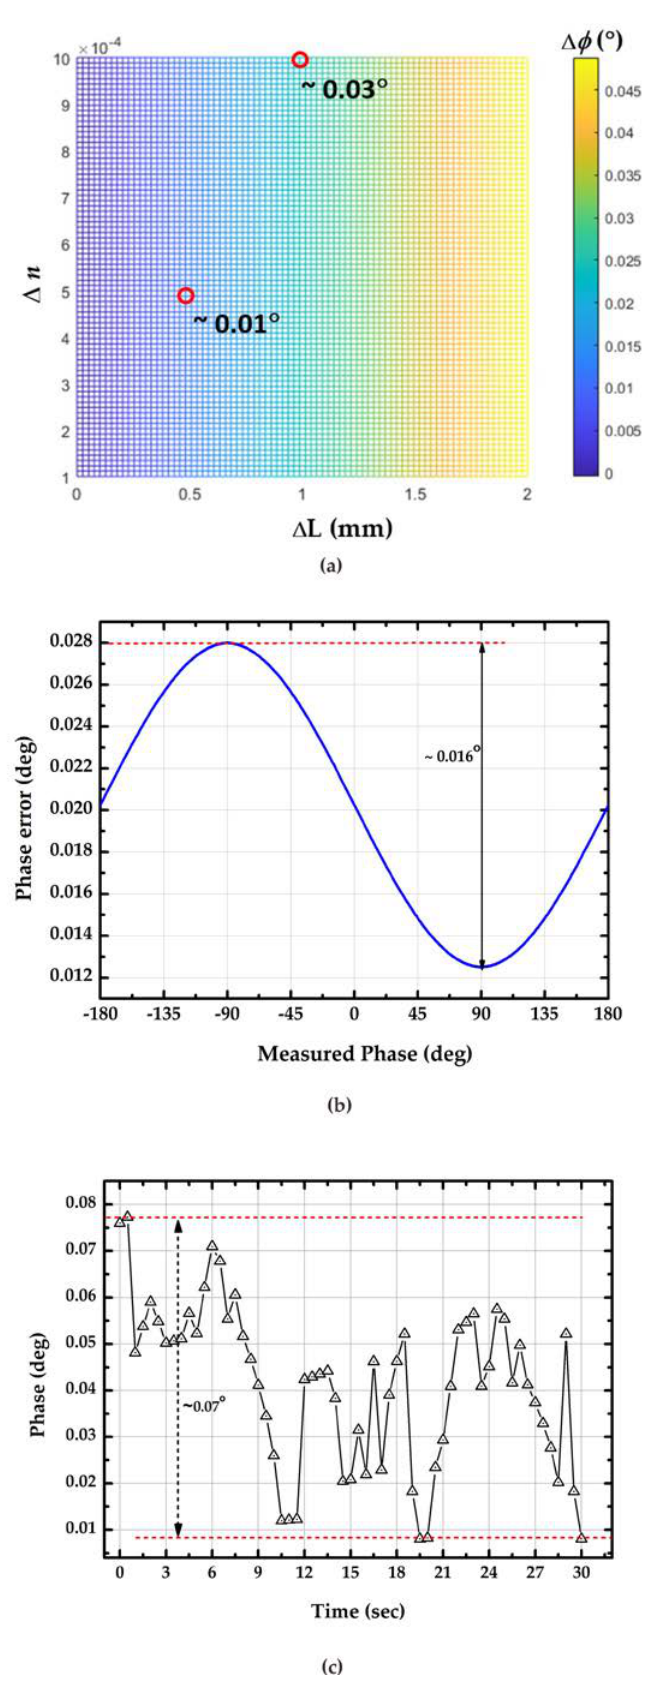
Figure 9. Phase error analysis of the proposed sensor. ( a ) Contribution of sensor length tolerance and variation of n ; ( b ) residual phase error; ( c ) phase stability of the proposed method.